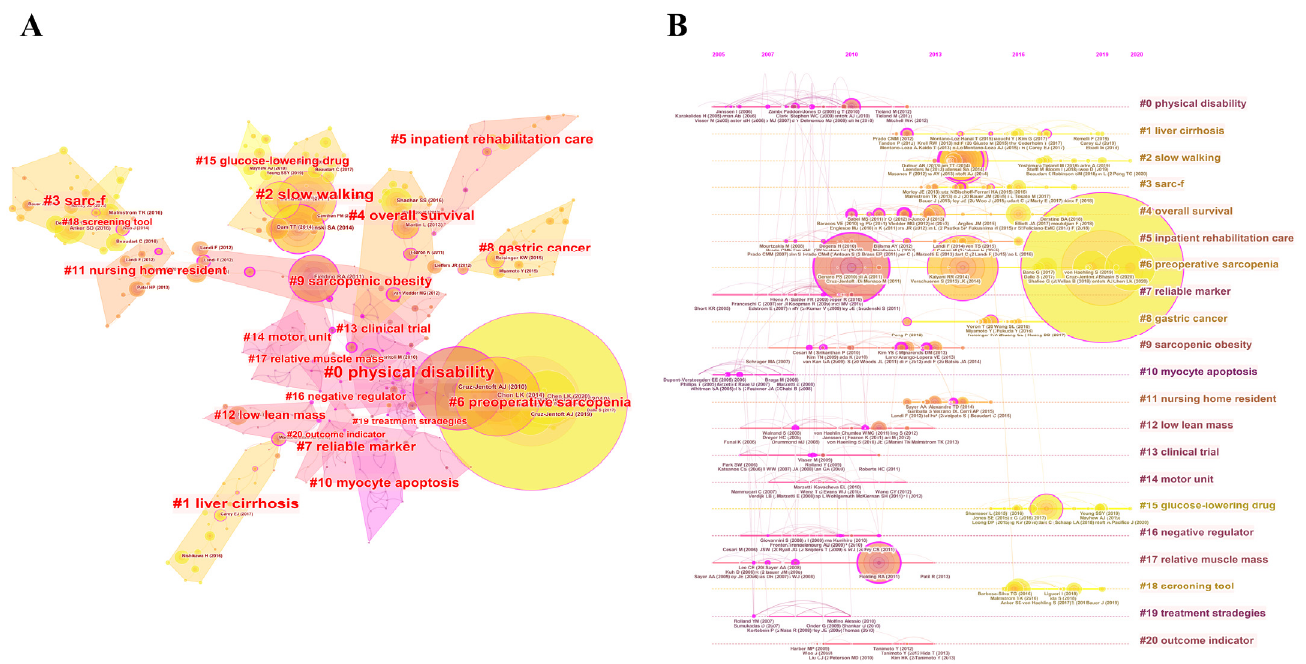
Figure 7. ( A ) The cluster view of the document co-citation network, generated by the top 50 docu- ments per slice between 2010 to 2021. ( B ) The timeline view of the document co-citation network.